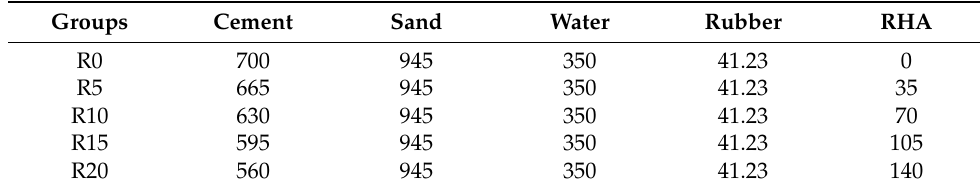
Table 2. Mix proportions of mortars (kg/m 3 ).